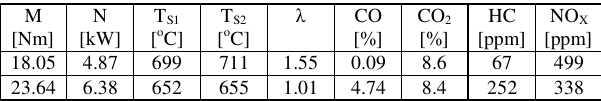
Table 9. Measurement data of the operation of the engine powered by